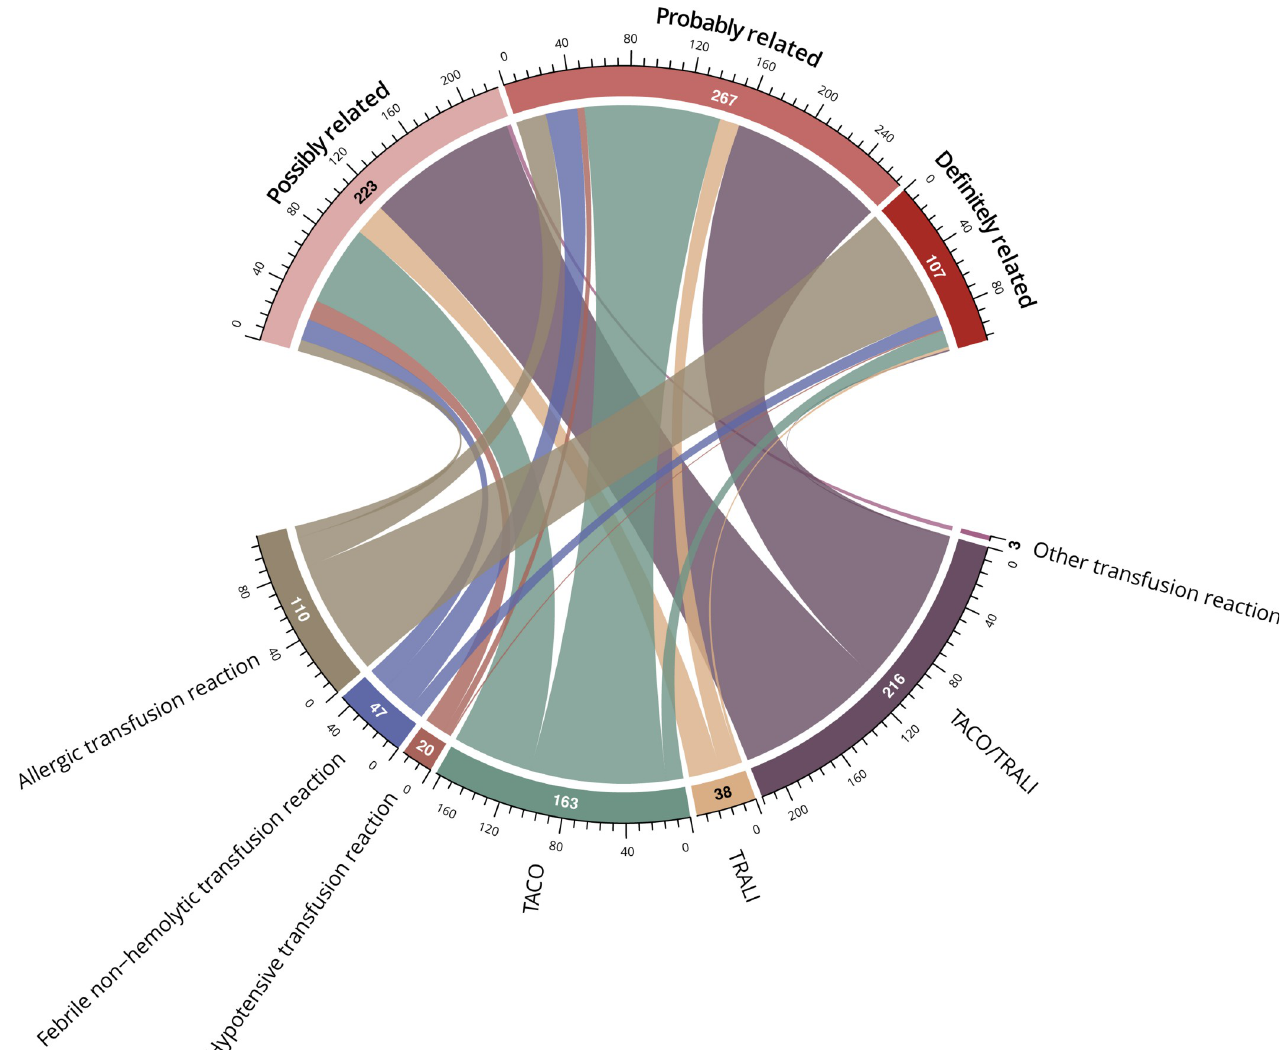
Fig 8. Chord diagram of the attributions associated with serious transfusion reactions. Attribution to a category of relatedness is depicted by a line connecting from each serious transfusion reaction type. The width of each line and the circumferential axis indicate the number of patients in each combined serious transfusion reaction and relatedness category group. Other transfusion reactions that were adjudicated to be possibly related to the transfusion ( n = 3) included leukomoid reaction ( n = 1), pulmonary embolism ( n = 1), and red cell dilution ( n = 1). TACO, transfusion-associated circulatory overload; TRALI, transfusion-related acute lung